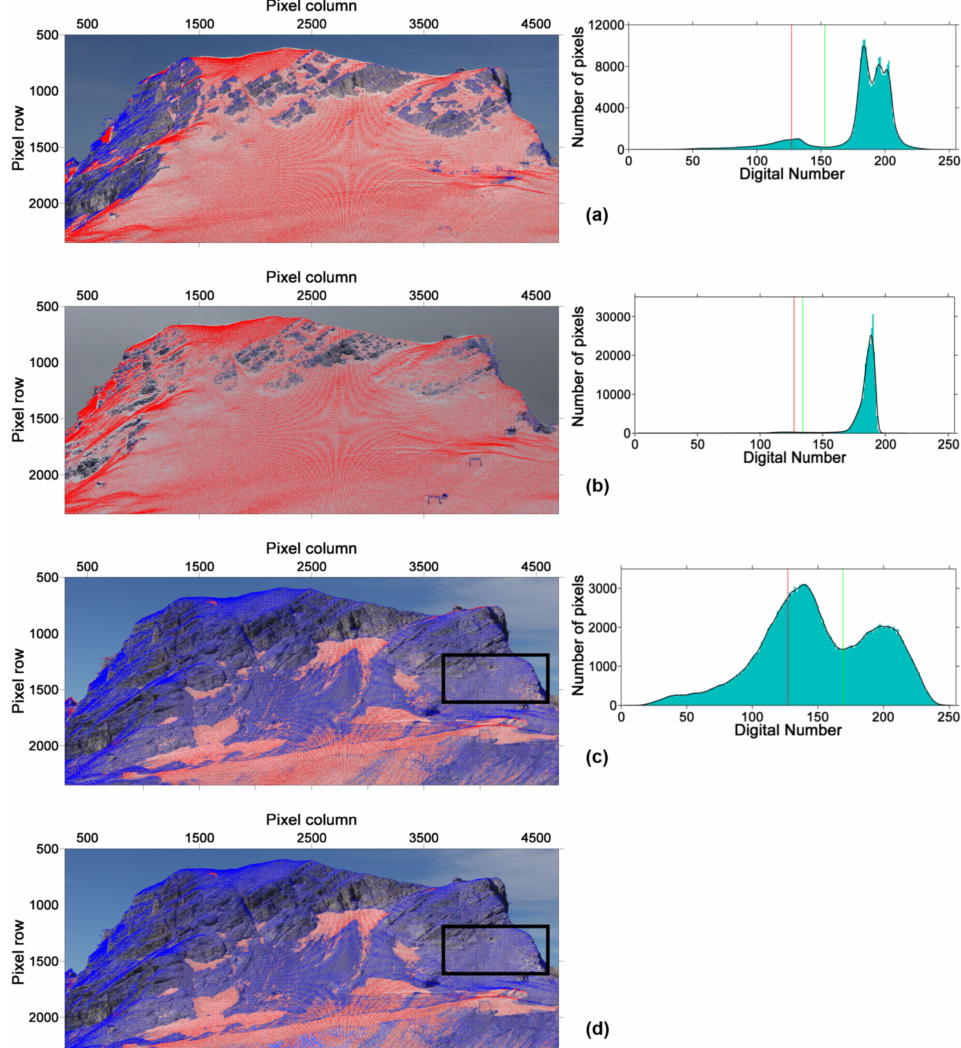
Fig. 9. The superimposition of the DEM pixels (red dots = snow, blue dots = no snow) over the corresponding and enlarged photograph are shown on the left for the automatically classified images under clear sky conditions in spring on 11 May 2011 at 08:15CEST (a) , under cloudy conditions in winter on 17 February 2012 at 15:07CET (b) , and under clear sky conditions in summer on 16 August 2011, 11:05CEST (c) , as well as for the manually reprocessed classification of the August image (d) . On the right, the corresponding snow thresholds (green lines) are illustrated: 153 (a) , 134 (b) and 169 (c) . The manual snow classification threshold is 169 for all three RGB bands and 10 for the maximum-minimum test (d) . The black box in (c) and (d) depicts a small test area in the investigation area at the Schneefernerkopf where visually no snow could be detected although several pixels are classified as